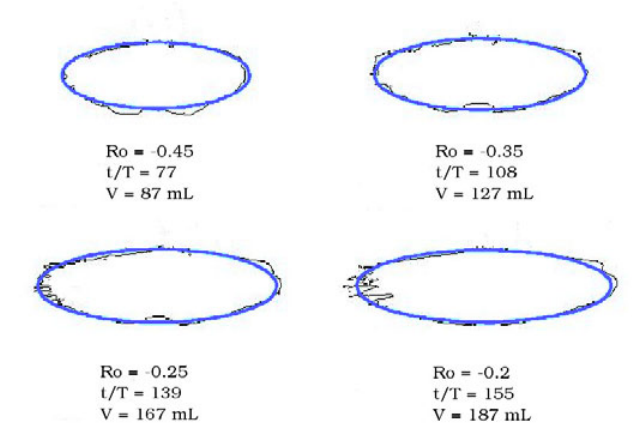
Figure 5. Image-processed side-view of a vortex boundary (white) at di ff erent times t with f = 6 . 8 rad / s and ¯ N = 1 . 6 rad / s held fixed. | Ro | decreases in time. Also shown are the theoretical boundaries (blue) of the model vortices at each time. T = 4 π/ f is the period of the rotating turntable.